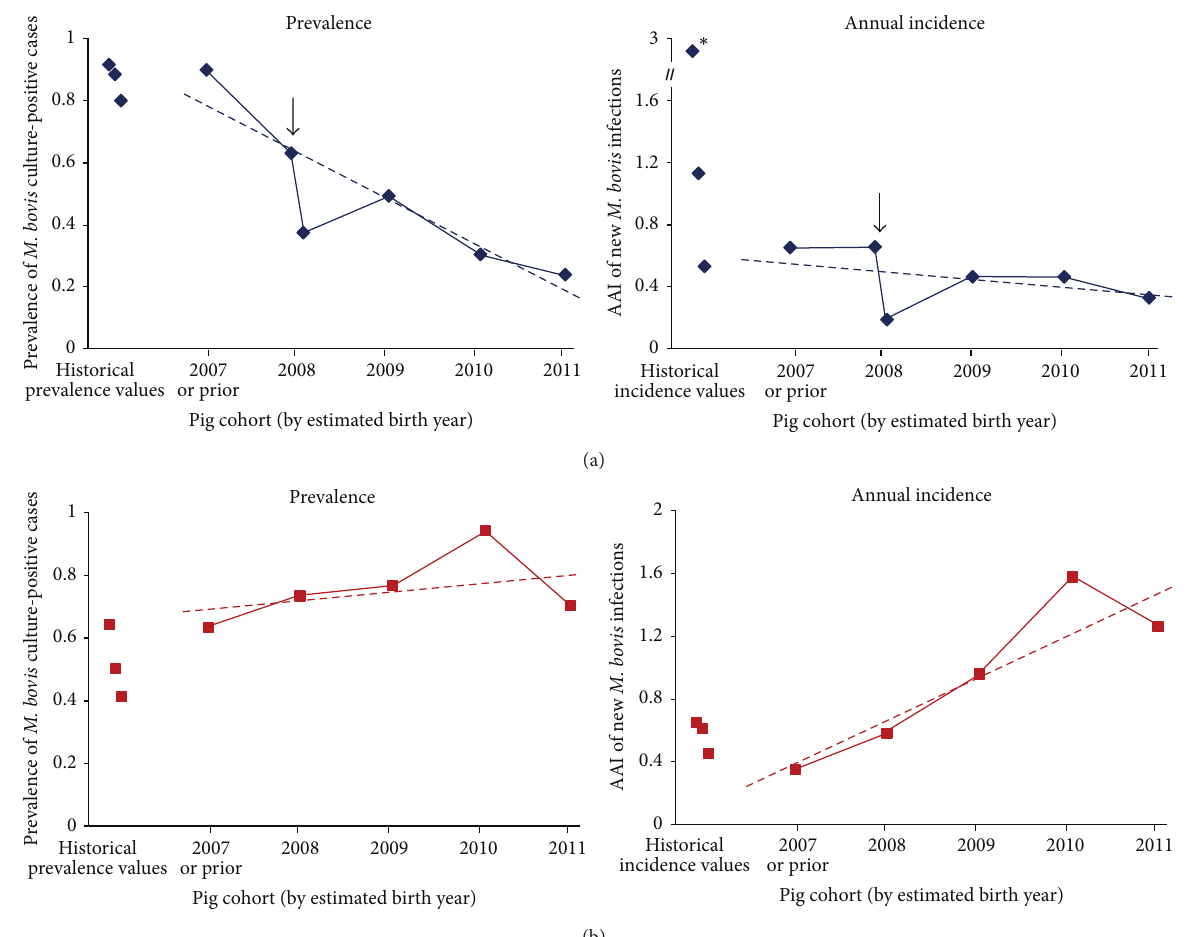
Figure 5: Trends in prevalence of culture-confirmed tuberculosis and of apparent annual incidence of new M. bovis infections among successive cohorts of pigs from Molesworth Station (a) and Clarence Reserve (b) study areas. Dashed lines represent 5-year linear trend lines fitted to the data from 2007 to 2011. Arrows refer to point of poison control of possums (Molesworth Station only) for which the 2008 cohort data were split into prepoison (Jan–Sept) and postpoison (Oct–Dec) portions. Historical prevalence/incidence values are presented for three sets of similar surveys conducted over the periods 1999–2003, 2003-2004, and 2005–2007; data in these historical surveys are presented for total pigs and are not differentiated according to birth year cohort. ∗ includes one set of Molesworth surveys in 2005–2007 where predominantly yearling pigs were sampled (mean age 7.8 months, 𝑛 = 40 ); hence an extremely high AAL value of 2.88 was